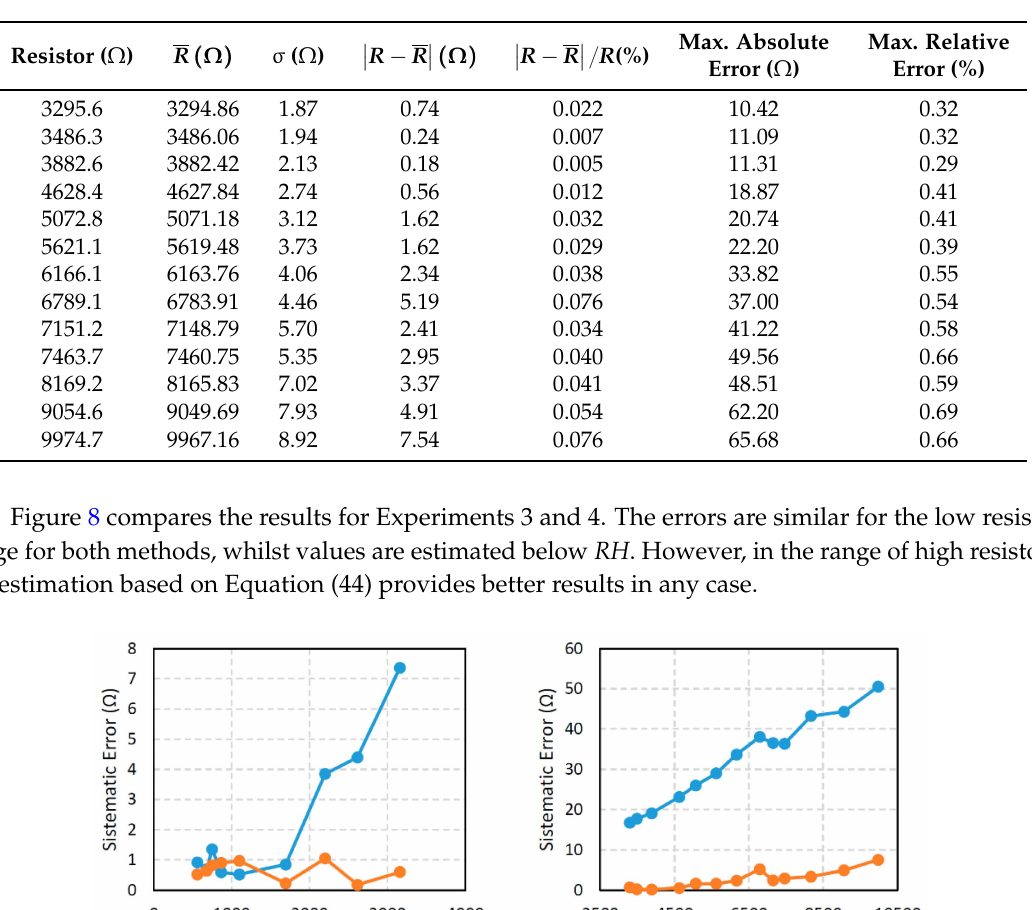
Table 6. Accuracy data for R ij estimation by using Equation (44) R P r 3296 Ω ,9975 Ω s .